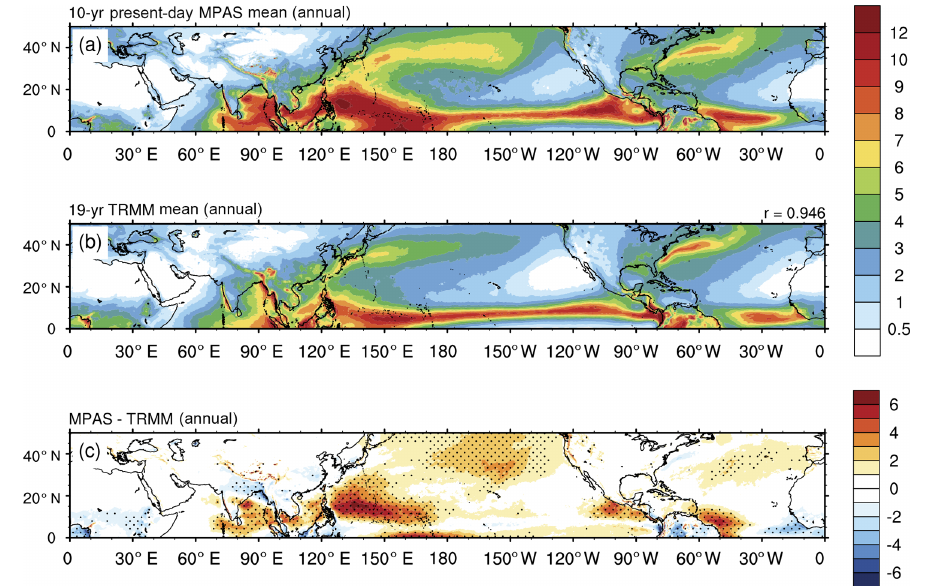
Figure 6. Average total annual precipitation (mmd − 1 ) for (a) present-day MPAS-A simulations, (b) TRMM 19-year climatology, and (c) the model bias (MPAS-A minus TRMM). MPAS-A output was linearly interpolated to the TRMM grid for point-to-point comparison. Pattern correlation coefficient is reported in the top right of panel (b) . Stippling in panel (c) indicates locations where the MPAS-A 10-year mean exceeds the range computed from 100 random samples of 10-year means from TRMM by more than 5% ( ∼ 1 . 2mmd − 1 ).